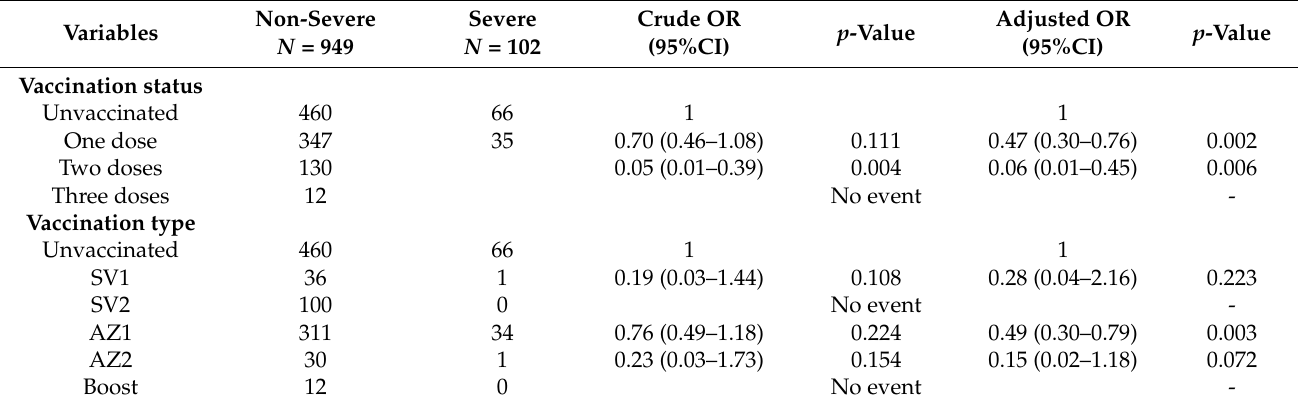
Table 3. Vaccine regimens associated with reducing severe